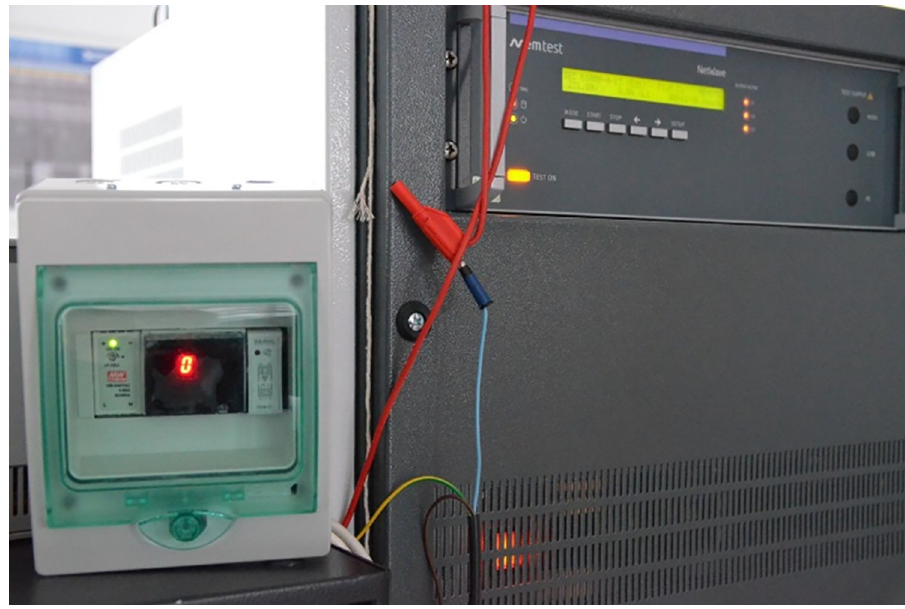
Fig 13. ELSA device during EMC